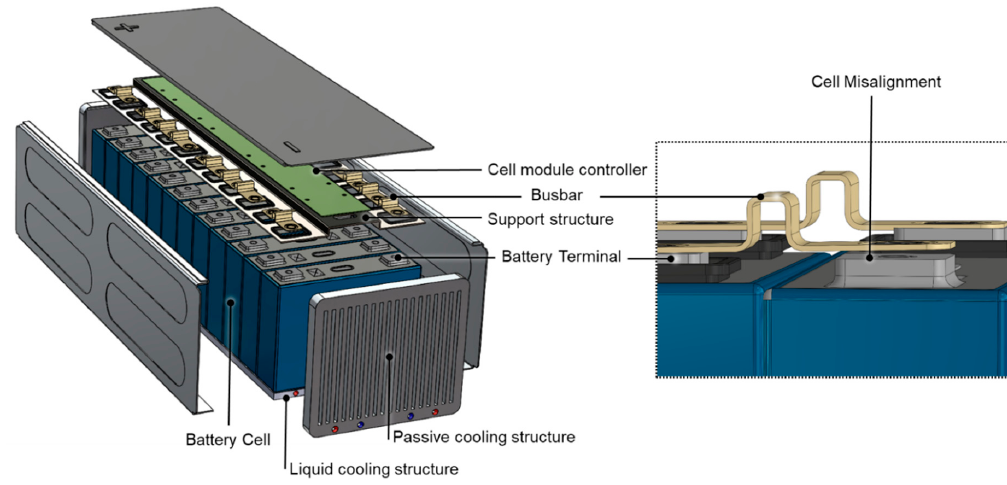
Figure 1. ( left ) Schematic representation of automotive battery module in assembly; ( right ) Detailed view of busbar-electrode interface to be measured on-line prior to welding.